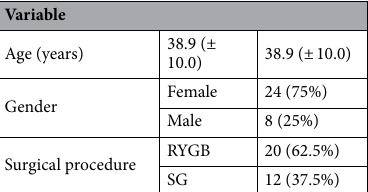
Table 1. Demographic description of the cohort of patients. Data presented as mean (standard deviation) or as n (percentage).